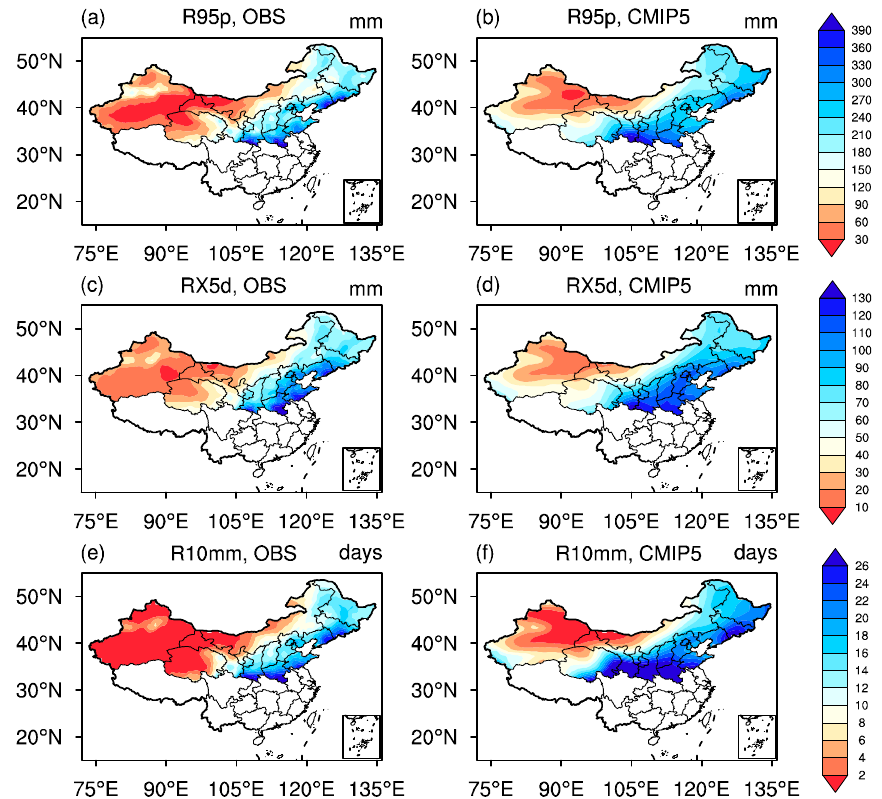
Figure 2. Spatial distribution of extreme rainfall indices over Northern China in the present day (1986–2005) with observations (left column), CMIP5 multi-model ensembles (middle column): ( a , b ) R95p (units: mm), ( c , d ) RX5d (units: mm) ( e , f ), and R10mm (units: days).